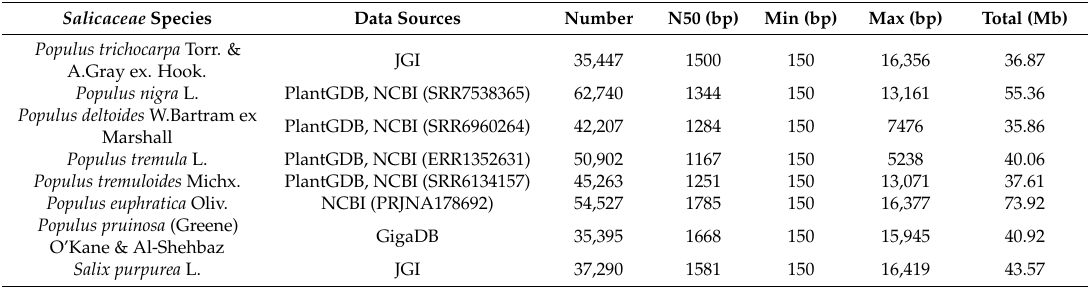
Table 1. Coding sequences (CDS) in eight Salicaceae